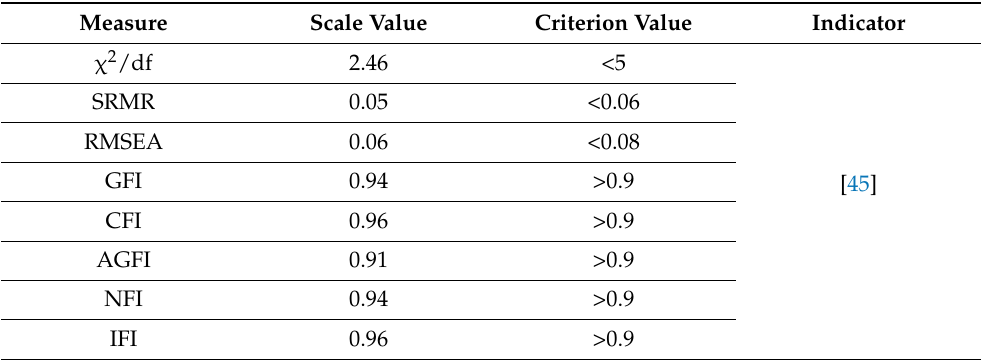
Table 4. CFA Model Fits of the Scale: χ 2 /df, SRMR, RMSEA, GFI, CFI, AGFI, NFI, and